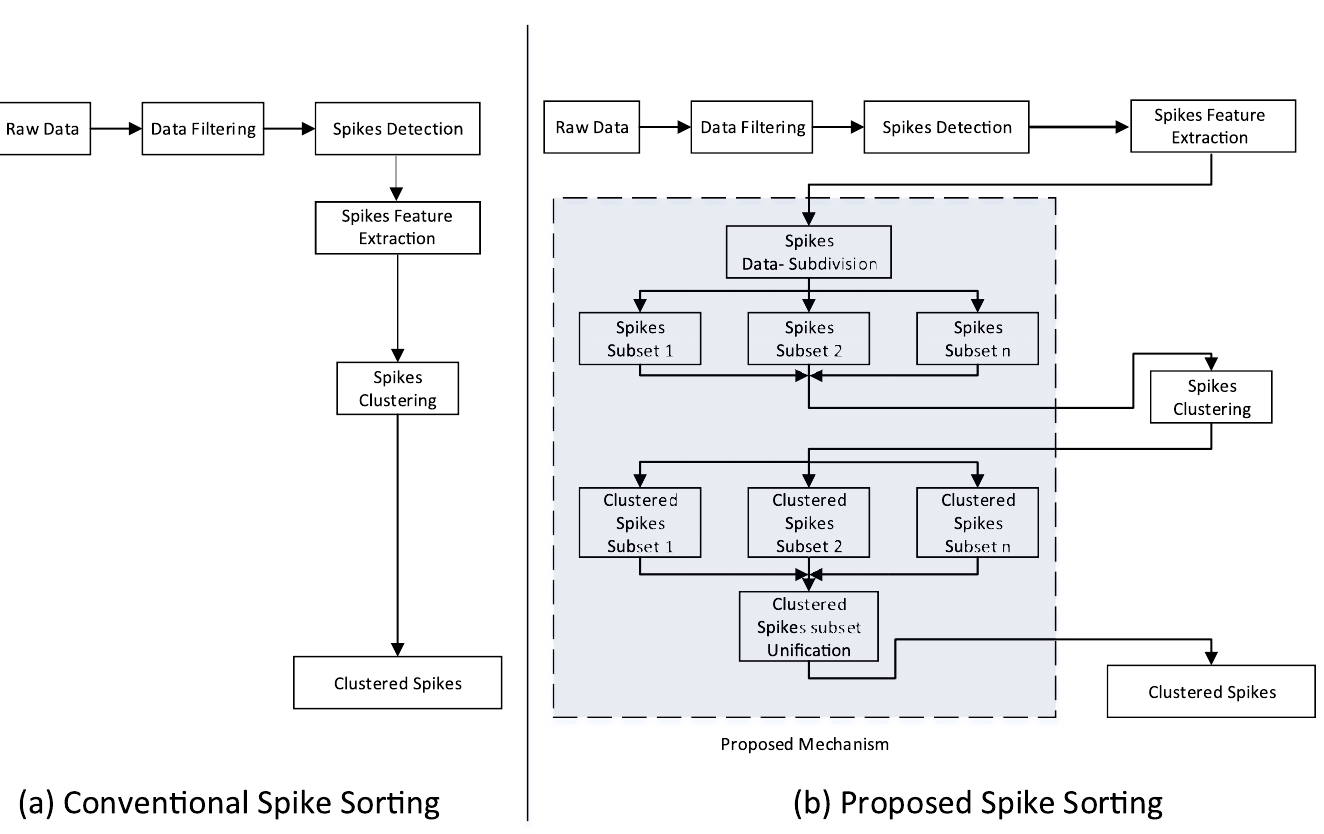
Fig 4. Comparison of conventional and proposed spike sorting